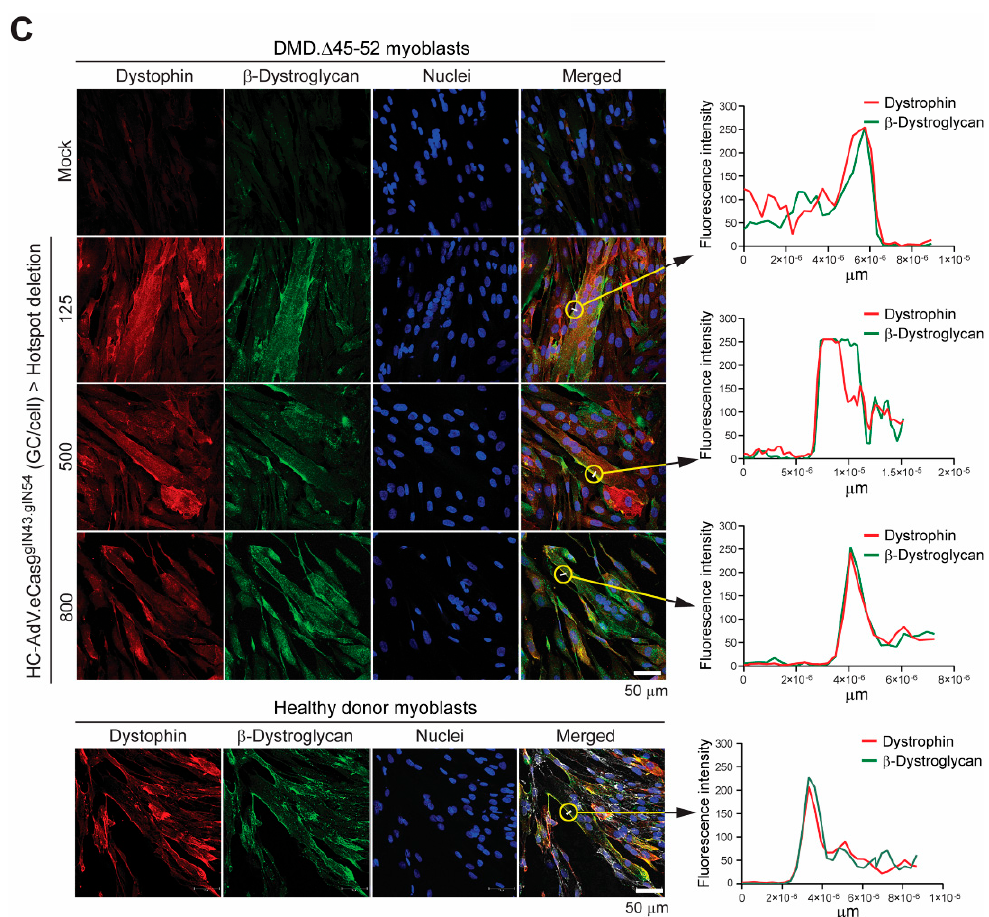
Figure 7. Assessing dystrophin rescue in DMD muscle cells after “all-in-one” HC-AdV transduction of single and dual RGNs. ( A ) Direct detection of dystrophin in populations of DMD edited muscle cells by western blot analysis. Western blotting was performed on myotubes di ff erentiated from myoblasts with the ∆ 45–52 and ∆ 48–50 genotypes previously transduced with HC-AdV.eCas9 gIN43.gIN54 or with HC-AdV.eCas9 gEX51 at the indicated MOIs. To serve as reference, western blotting was also carried out on various protein amounts from healthy donor myotubes. An antibody recognizing α / β -tubulin provided for a protein loading control. ( B ) Immunofluorescence microscopy analyses on muscle cells edited by HC-AdV particles encoding RGNs targeting DMD exon 51. Dual-color confocal microscopy for dystrophin and β -dystroglycan was performed on myotubes di ff erentiated from DMD. ∆ 48–50 myoblasts transduced with HC-AdV.eCas9 gEX51 at the indicated MOIs. ( C ) Immunofluorescence microscopy analyses on muscle cells edited by HC-AdV particles encoding dual RGNs targeting DMD introns 43 and 54. Confocal microscopy for dystrophin and β -dystroglycan was done on myotubes di ff erentiated from DMD. ∆ 45–52 myoblasts transduced with HC-AdV.eCas9 gIN43.gIN54 at the indicated MOIs. Healthy donor (wild-type) myotubes served as positive controls; GC / cell: genome copies per cell. In panels B and C , co-localization of dystrophin and β -dystroglycan molecules across the plasma membrane of gene-edited DMD myotubes was confirmed by measuring the fluorescence intensities of dystrophin- and β -dystroglycan-specific signals at the encircled locations. Nuclei were labeled with the DNA dye